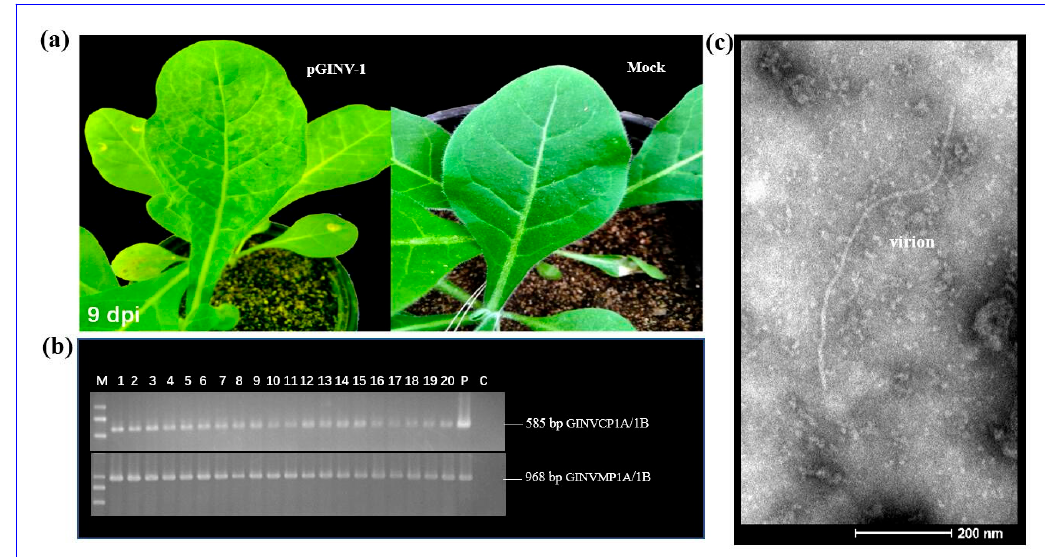
Figure 2. Inoculation of N. occidentalis plants using the GINV full-length infectious cDNA clone pGINV-1. ( a ) Infectivity test of pGINV-1 in N.occidentalis plants. The agroinoculated N. occidentalis plants behaved chlorotic mottle at 9 days postinoculation (dpi). Mock, infiltrated with agrobacterial plants using primer pairs GINVCP1A / 1B and GINVMP1A / 1B. Lanes 1–20, agroinoculated N.